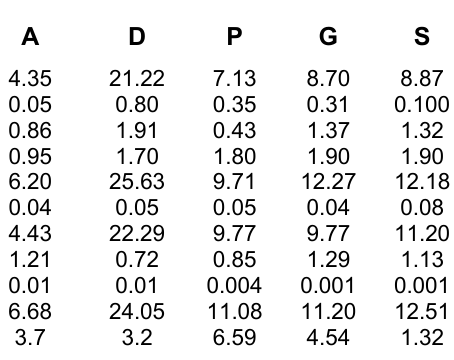
Sediment Sample Element Released from